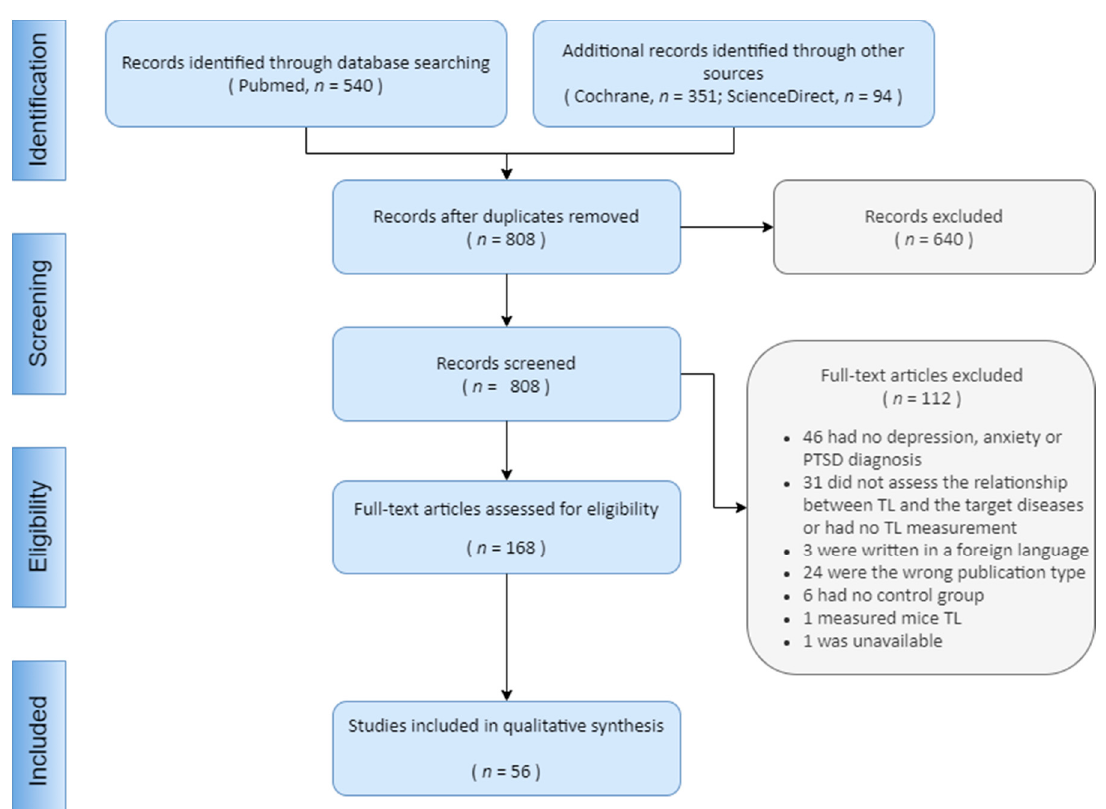
Figure 2. Flow diagram of study selection.